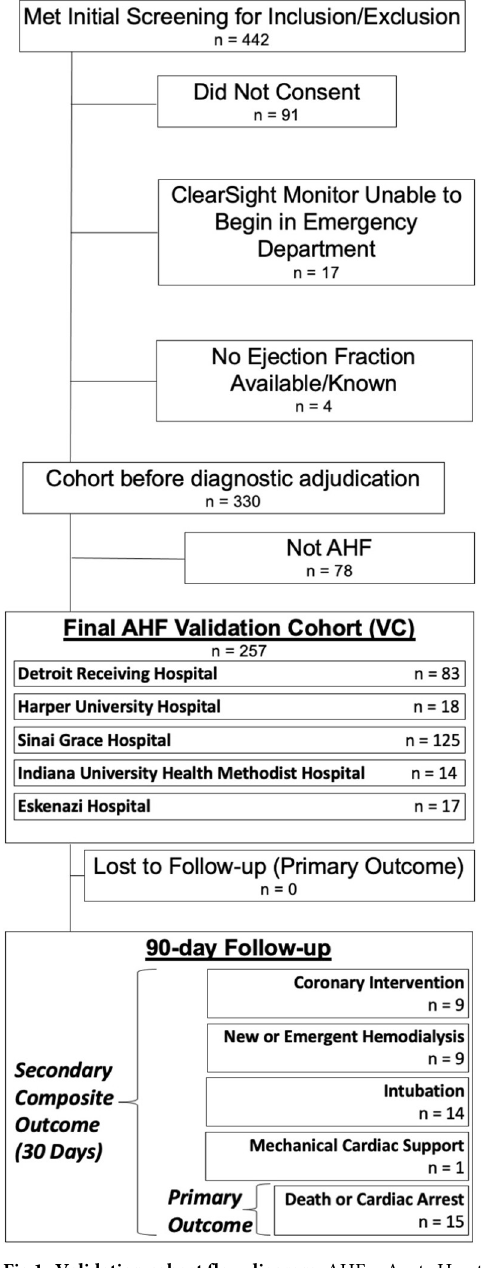
significant differences in SBP (p = 0.461) or DBP (p = 0.933) between profiles, which aligns with our prior published work on this device in an ED population of AHF patients [14] show- ing only moderate to low correlation of SVRI to device-estimated DBP (r = 0.587), SBP (r = 0.324), and mean arterial pressure ({MAP}, r = 0.479). The 3 validated clinical risk scores (EHMRG, GWTG-HF, and STRATIFY) had no statisti- cally significant difference between profiles (Table 1).